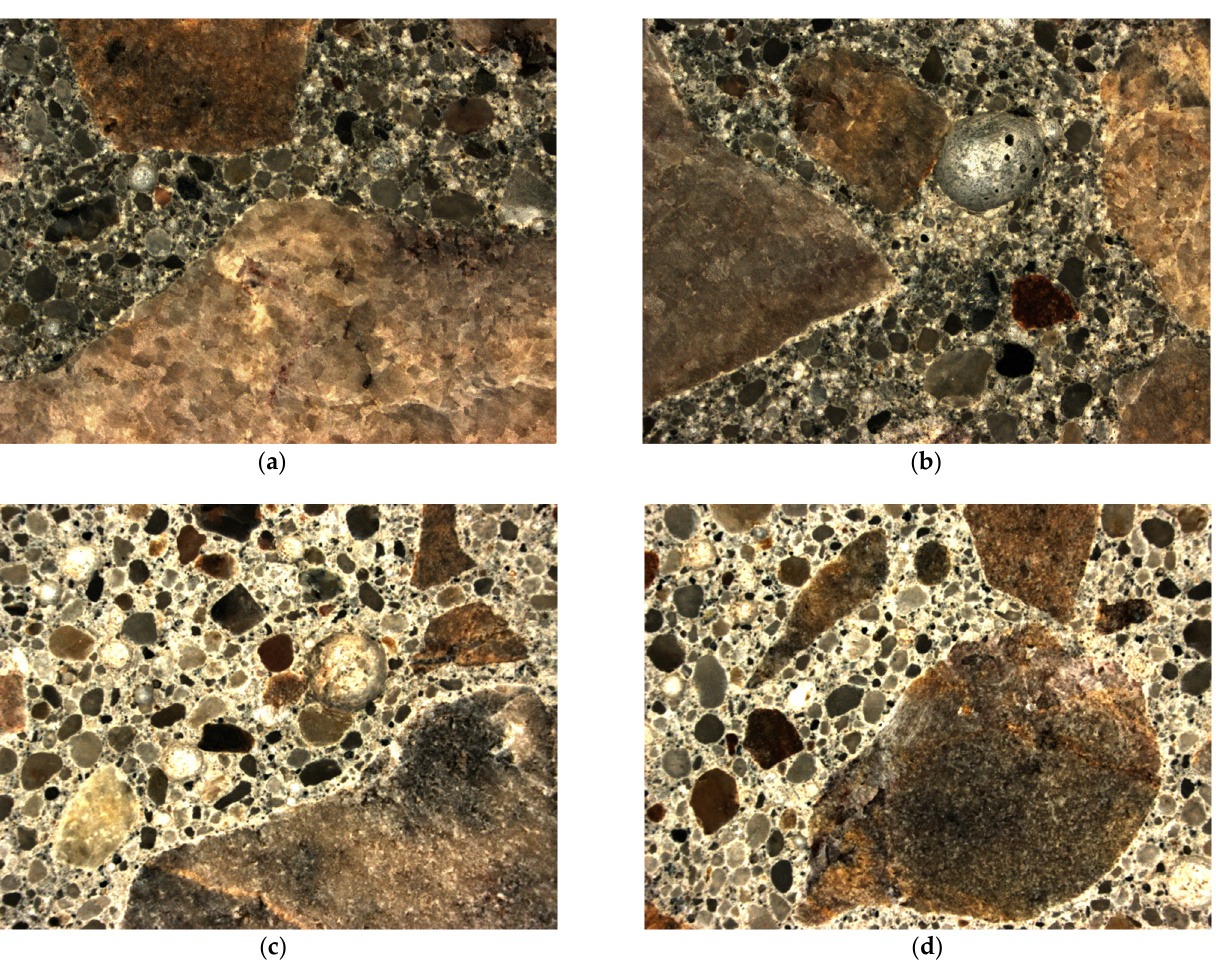
Figure 4. The image of the tested concrete samples after cutting: ( a ) and ( b ) C_I; ( c ) and ( d ) C_III.